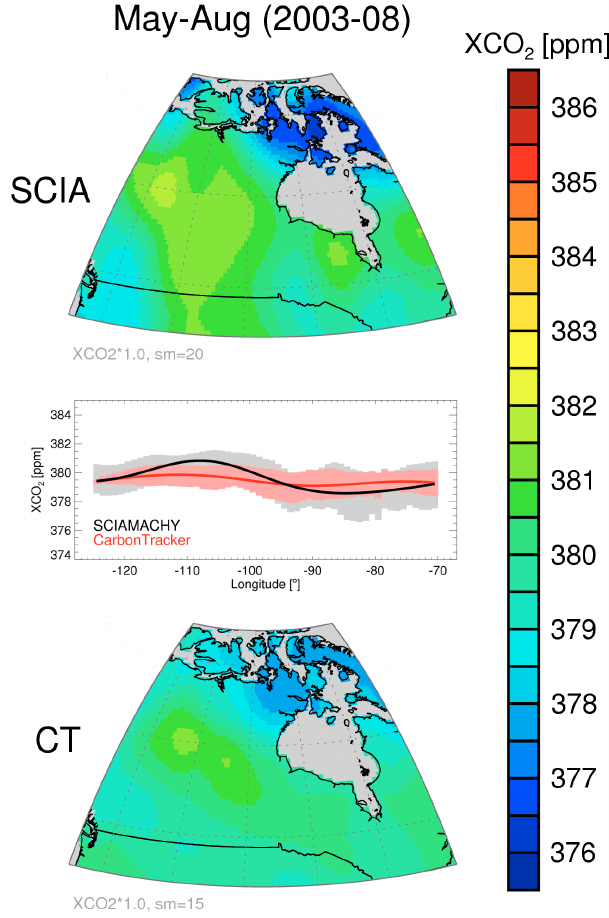
Fig. 9. Seasonally averaged (May–August) SCIAMACHY (top) and CarbonTracker (bottom) XCO 2 during 2003–2008 over the North American boreal forest slice motivated in Fig. 6 showing the spatial pattern during the growing season which leads to the longi- tudinal gradients of Fig. 7a. The middle panel shows the gradients based on the smoothed pattern shown here derived by fitting linear combinations of a Gaussian and a quadratic polynomial.